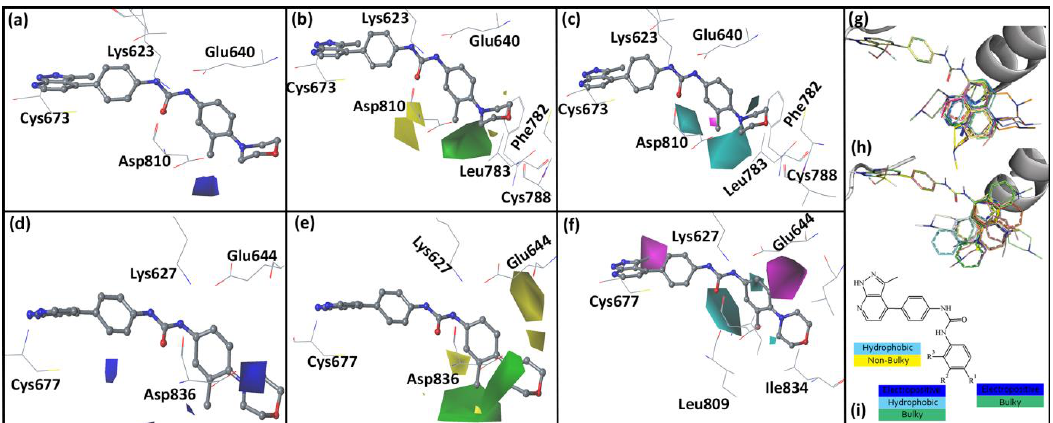
Figure 2. Contour maps generated based on the CoMFA and CoMSIA models for c-KIT and PDGFRα with compound 14 used as a reference. Blue and red contours indicate electropositive and electronegative substituents’ favorable regions, respectively. Green and yellow contours indicate steric bulk substituents’ favorable and unfavorable regions, respectively. Cyan and purple colors contours represent hydrophobic favorable and unfavorable regions. ( a ) Electrostatic contour map for the c-KIT CoMFA model. ( b ) Steric contour map for the c-KIT CoMFA model ( c ) Hydrophobic contour map for the c-KIT CoMSIA model. ( d ) Electrostatic contour map for the PDGFRα CoMFA model. ( e ) Steric contour map for the PDGFRα CoMFA model. ( f ) Hydrophobic contour map for the PDGFRα CoMSIA model. Alignments used for